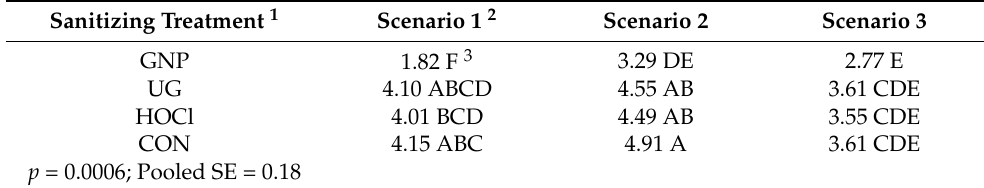
Table 1. Escherichia coli O157:H7 survivors (log 10 CFU/cm 2 ) on tomato skin samples by the sanitiza- tion treatment × experimental contamination/sanitization scenario interaction.